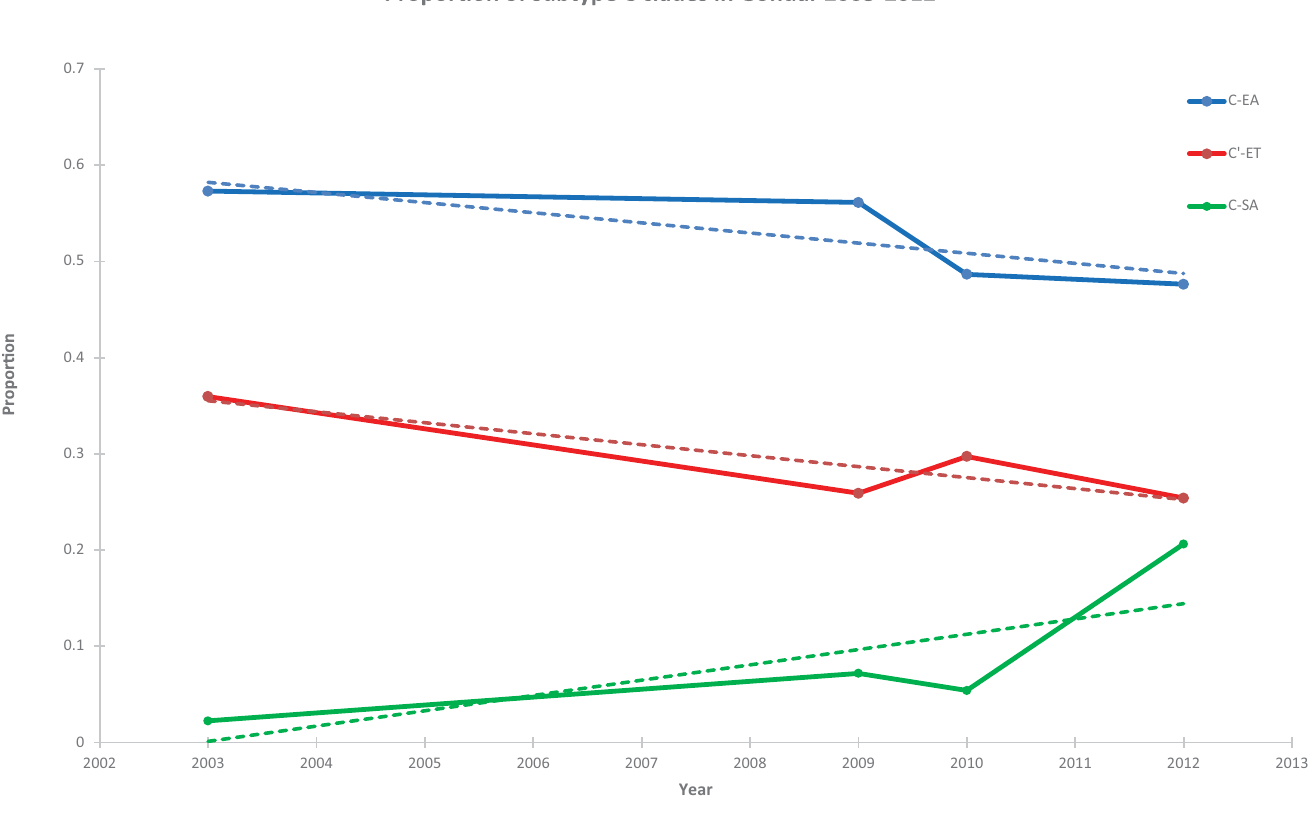
Fig 1. Trend analysis of subtype C clades 2003–2013. Proportion of different subtype C clades in Gondar 2003–2013. A dotted line indicates the trend over time. The 2012 time point included specimens obtained 2011–2013 (current study).